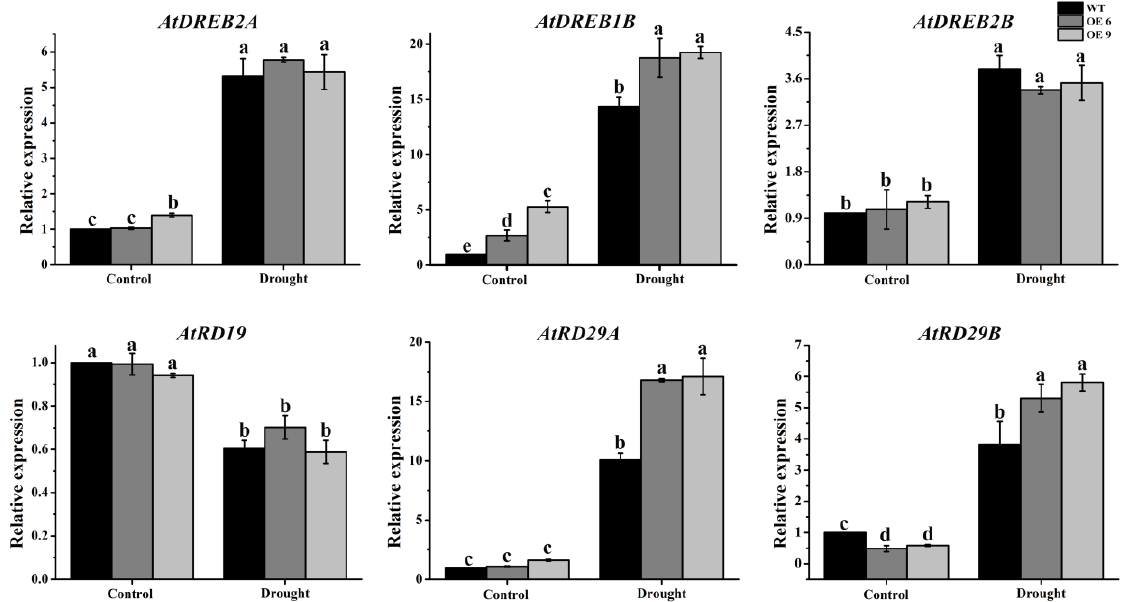
Figure 9. Effects of water deficit on the transcription changes of multiple drought responsive genes in Arabidopsis TaTIP4;1 overexpressors. Fifteen-day-old WT, VC and TaTIP4;1 transgenic plants were dehydrated for 6 h. Gene expression was detected by quantitative real-time RT-PCR (qRT-PCR) method, AtActin2 was used as the internal control. Data are mean ± SD (n ≥ 3). Diverse lowercase letters above the error bars show significant differences in the values among the plants by one way ANOVA and Tukey’s HSD test ( p < 0.05).